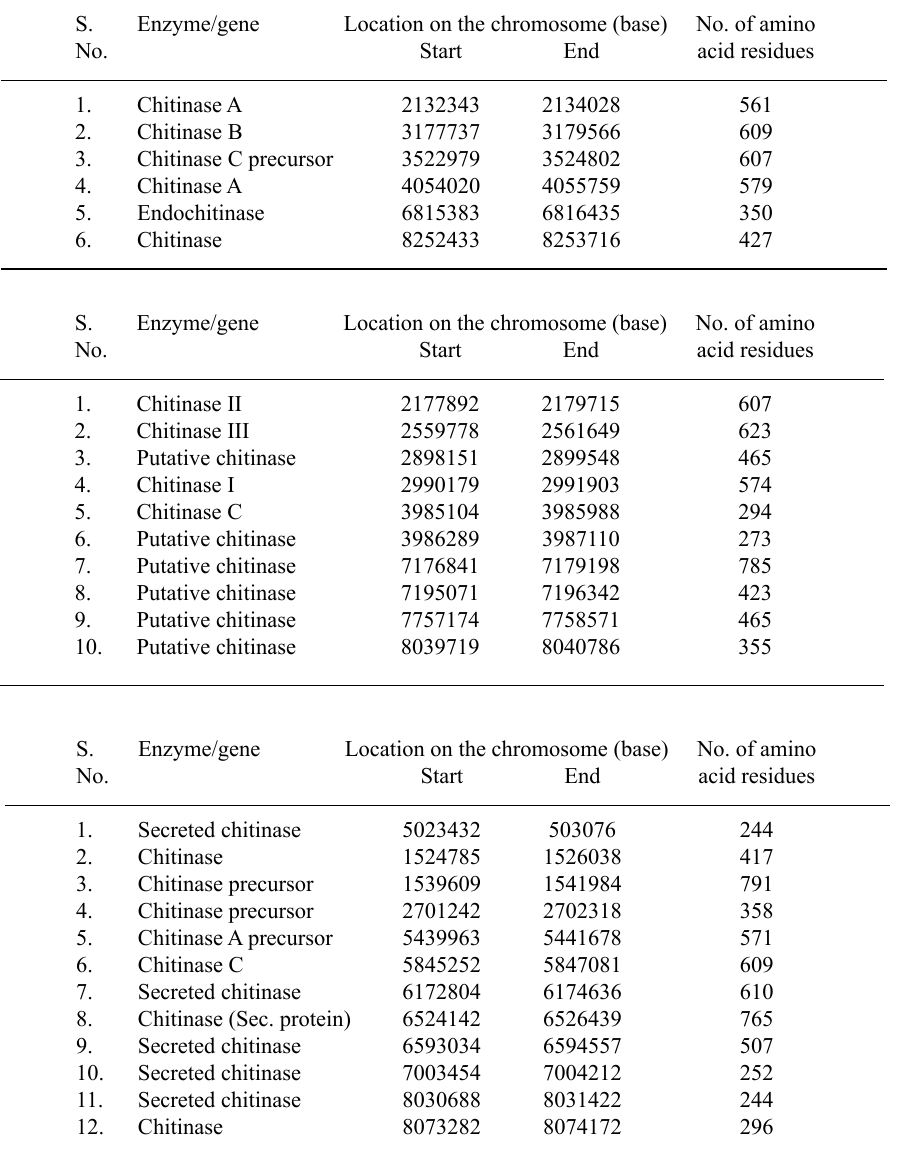
Table 1. Chitinase genes present in the genome of S. avermitilis 10 , S. griseus 11 and S. coelicolor